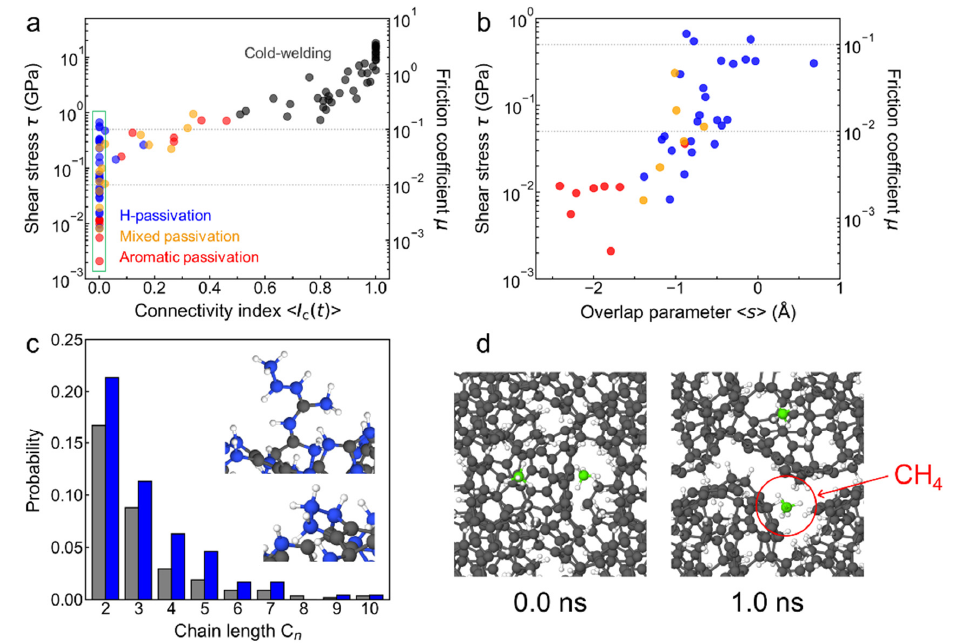
Figure 3. ( a ) Shear stress τ and friction coefficient µ as a function of ( a ) the averaged connectivity index (cid:104) I c ( t ) (cid:105) and ( b ) the averaged overlap parameter (cid:104) s (cid:105) . In panel ( b ), all trajectories where (cid:104) I c ( t ) (cid:105) = 0 are considered (indicated by a green rectangle in panel ( a )). Yellow, red, and blue markers are results of mixed, aromatic, and hydrogen-passivated surfaces, respectively. ( c ) Probability of hydrocarbon chain length C n before (gray) and after 1-ns sliding (blue). The chain length is calculated by analyzing the connectivity of carbon atoms bound to hydrogen atoms. All trajectories of a-C:H with C H > 30.0 at.% are considered. The insets represent examples of the oligomerized surface for a-C:H with C H = 37.0 at.% after sliding. Carbon atoms bonded with hydrogen atoms are presented by blue spheres. ( d ) Example of outgassing of methane stored in the a-C:H matrix under shear. Carbon atoms in the methane molecules are colored in